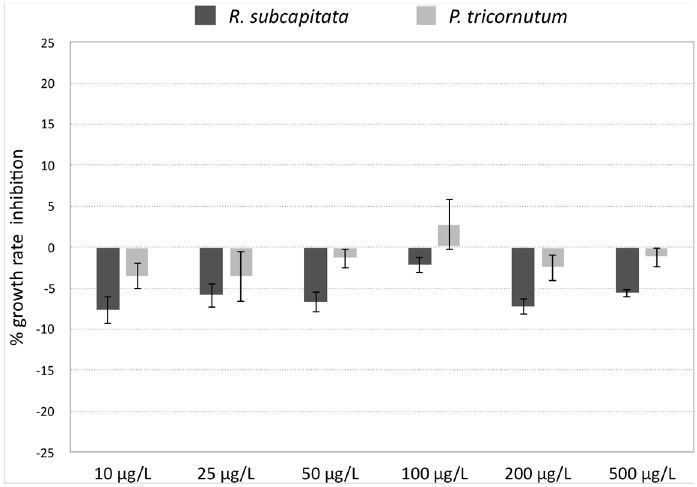
Figure 5. Percentage of growth rate inhibition compared to control of R. subcapitata and P. tricornutum exposed to AgNPs (10, 25, 50, 100, 200, 500 µ g / L) for 72 h. Data are shown as mean ± standard